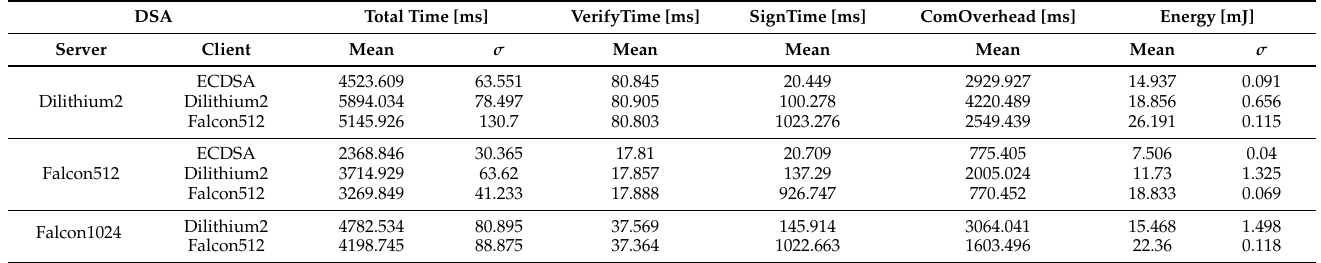
Table A2. The measured latency and energy consumption of the TLS 1.2 handshakes with KYBER512 and post-quantum DSAs. σ denotes the standard deviation of the